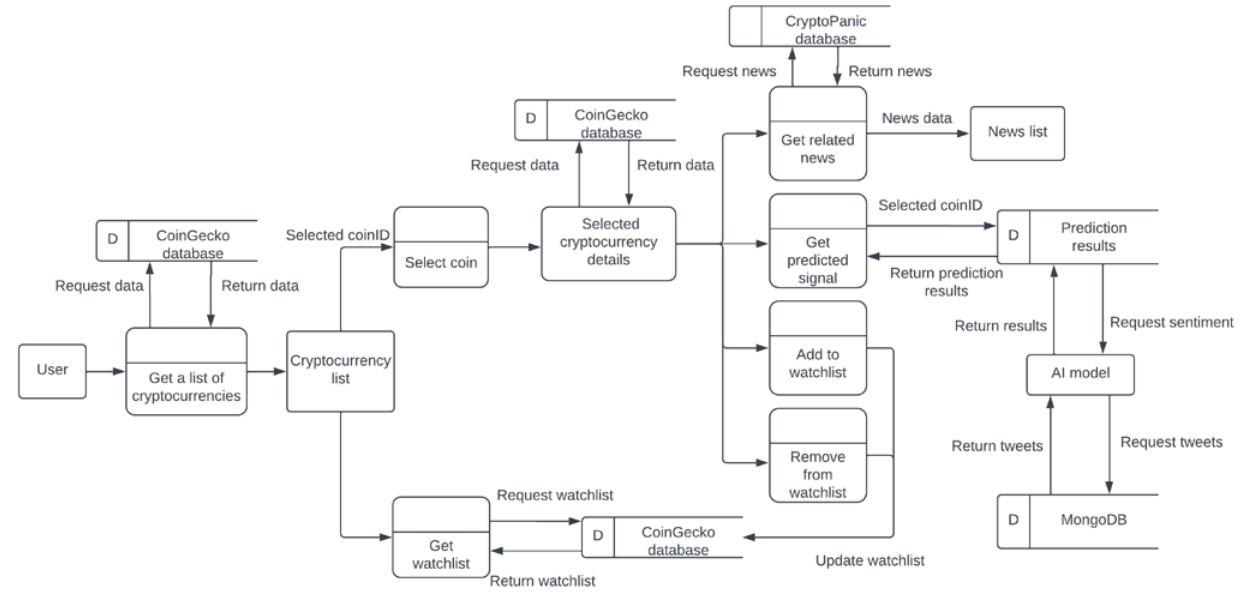
Figure 2. Data-flow diagram of the proposed system. Figure 2. Data- flow diagram of the proposed system.